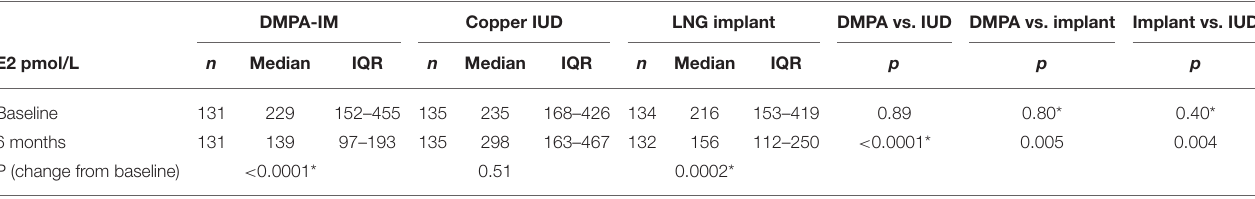
TABLE 2 | Estradiol results expressed as median values (interquartile